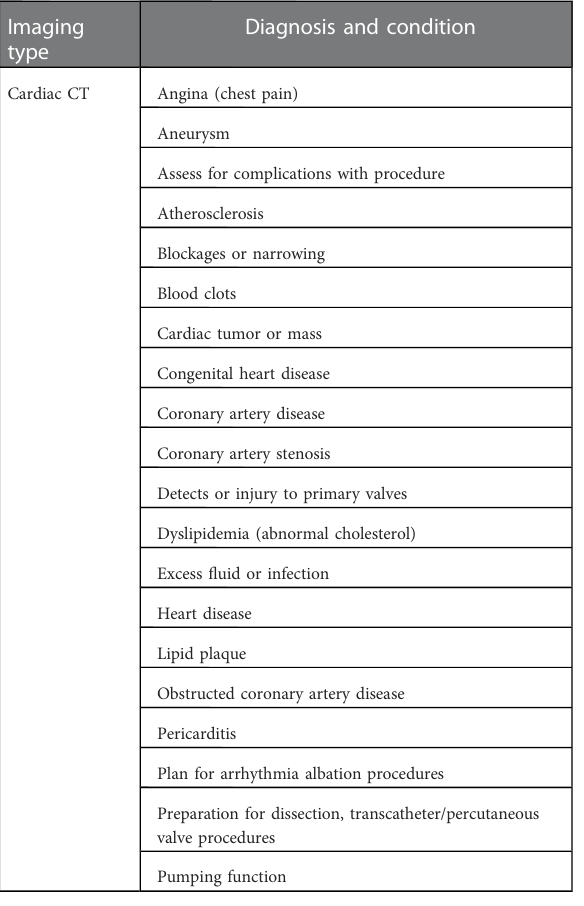
TABLE 5 Medical condition and diagnosis that can be identi fi ed by using cardiac CT scanning. Imaging